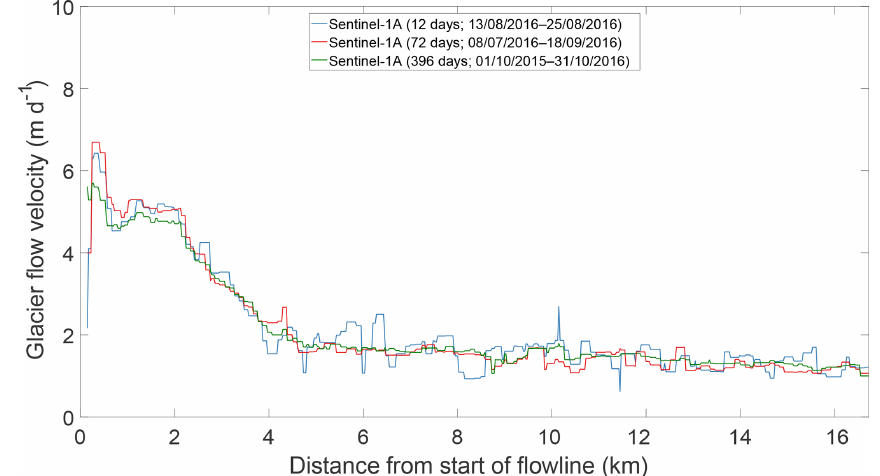
Figure 11. Mean flow velocity along the central flowline (see Fig. 1) for different temporal integration periods. Shorter periods are more prone to noisy results but offer higher temporal resolution, while an increase in temporal integration time smoothens the